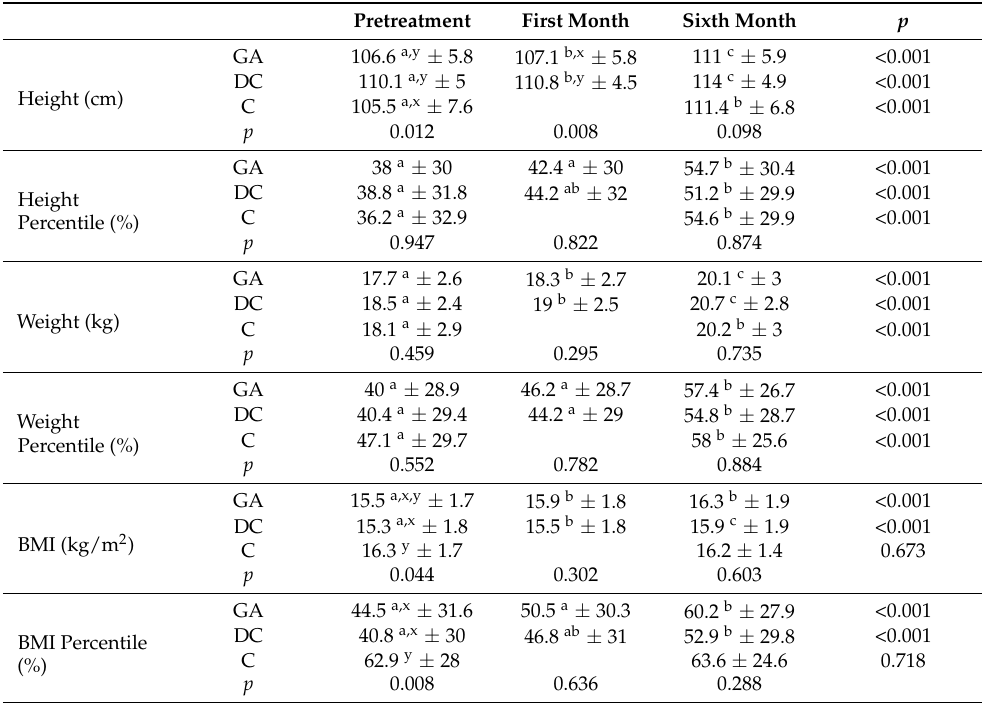
Table 5. Anthropometrical and percentile values of the study groups measured at the different stages of the study (Mean ± Standard